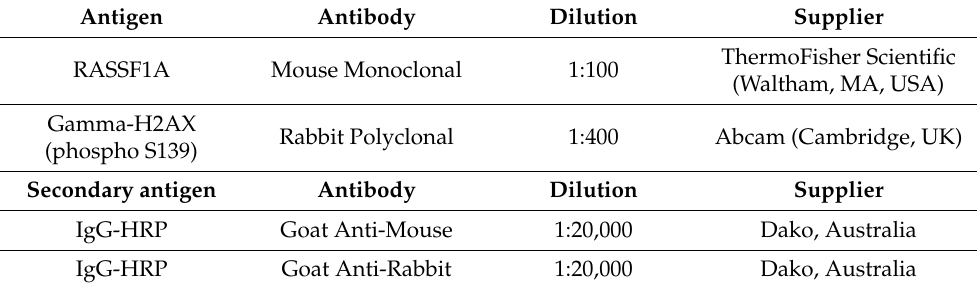
Table 3. Antibodies used in the current